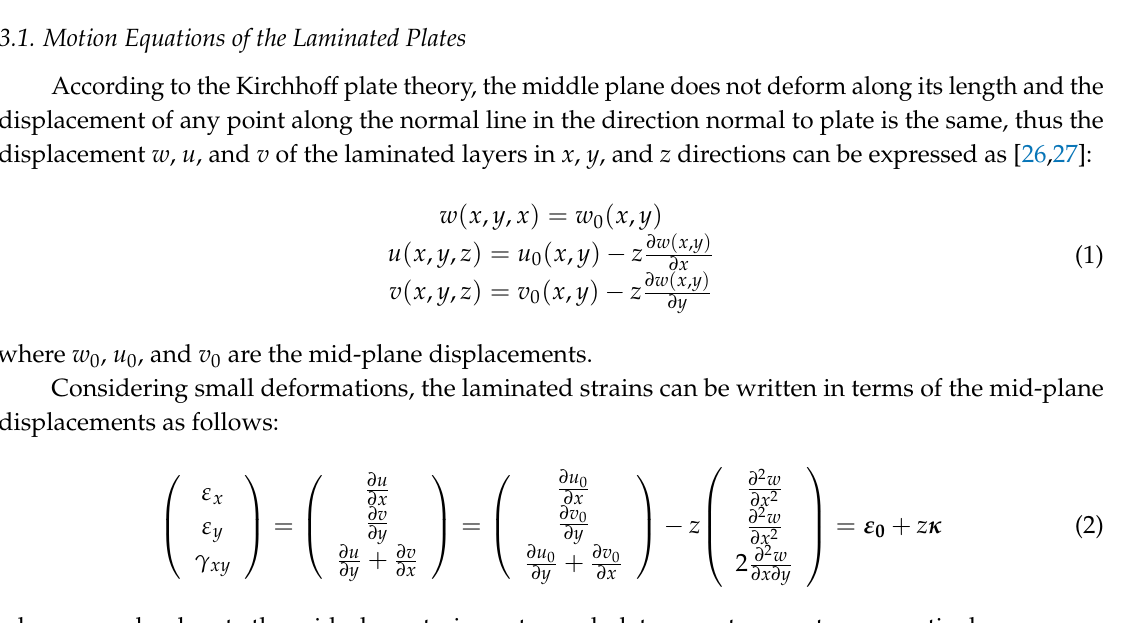
Table 1. Structural parameters of the single-element DFUT in the glossary of symbols. Structural Parameter Symbol Length of the nonpiezoelectric elastic layer l Length of the piezoelectric layer a Thickness of the nonpiezoelectric elastic layer t 1 Thickness of the middle metal electrode t 2 Thickness of the piezoelectric layer t 3 Thickness of the top metal electrodes t 4 Thickness of the central suspended elastic layer t s Height of the middle plane from the bottom surface z m Distance from the bottom reference surface z